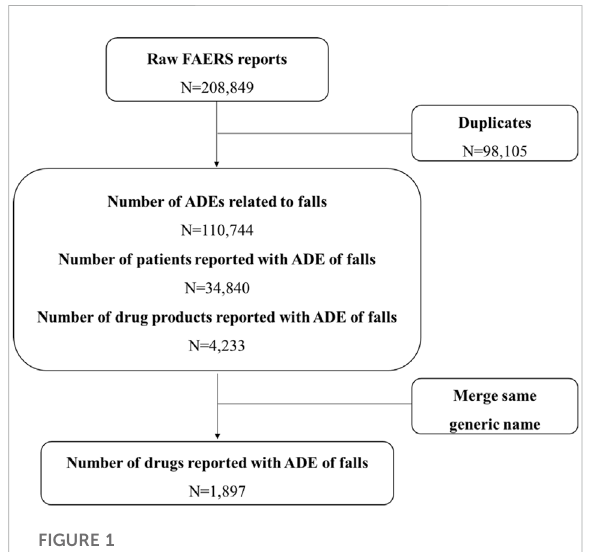
FIGURE 1 Flow chart for identi fi cation of fall reports of suspected adverse events FAERS, FDA Adverse Event Reporting System; ADEs, Adverse Drug